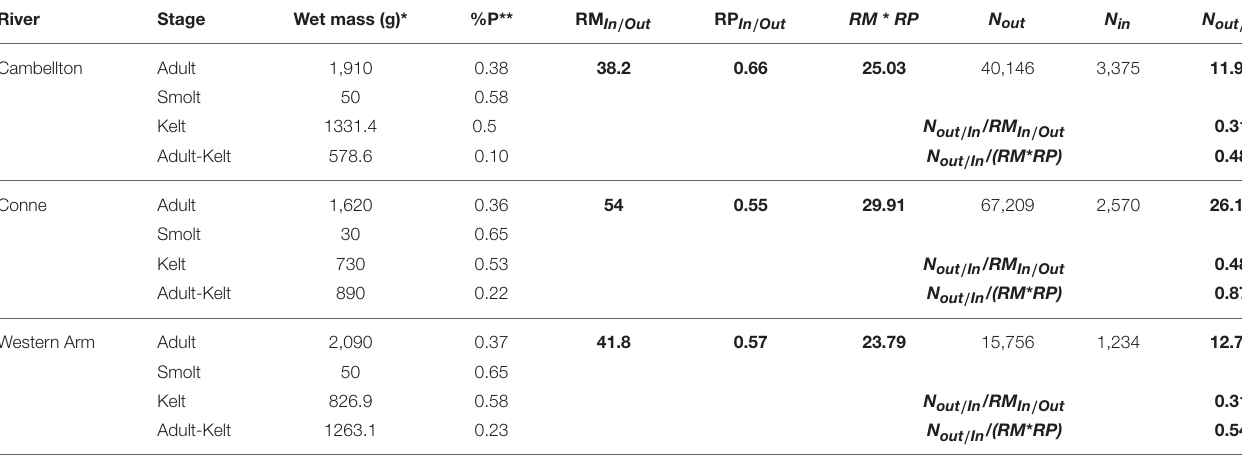
TABLE 2 | Summary of Atlantic salmon adult, smolt, and kelt size and P content by river from Ebel et al. (2015) with derived model parameters (boldface).